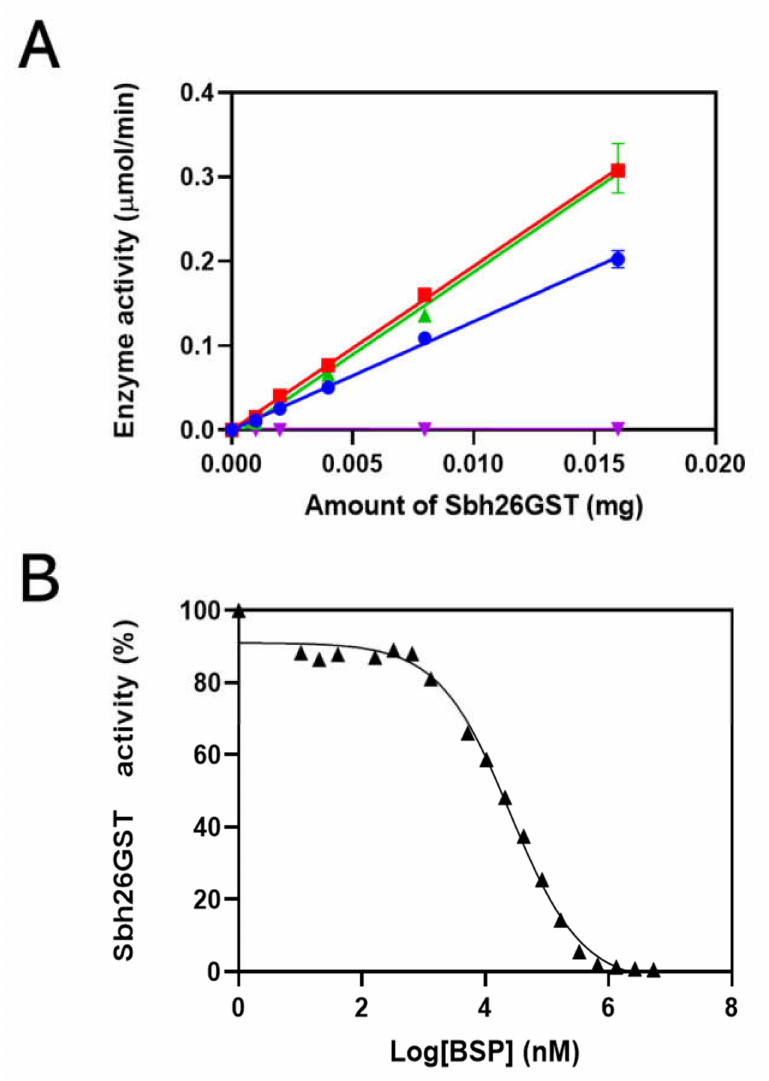
Figure 3. Specific activity analysis of Sbh26GST. ( A ) The specific activity was determined by varying the concentration of Sbh26GST when performing the GSH–CDNB assay and was found to be 13 µ mol/min/mg in the absence of any ligand ( blue ). In the presence of 0.5 mM BSP ( purple ) the activity decreased to 0.07 µ mol/min/mg, whereas in the presence of 0.5 mM PZQ ( red ) or 0.5 mM ART ( green ), the activity increased insignificantly to 19 µ mol/min/mg. ( B ) the concentration of BSP was varied while performing the CDNB assay with 100 nM Sbh26GST to determine its IC 50 , which was found to be 27 µ